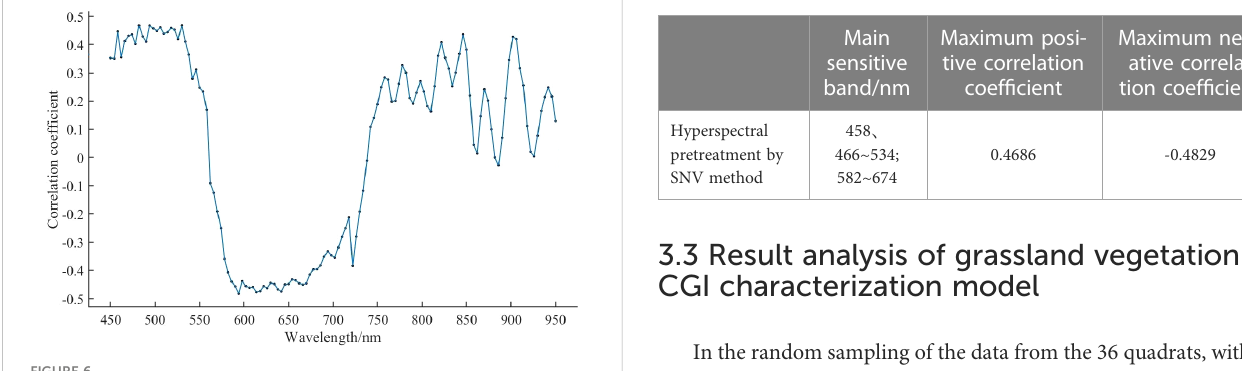
FIGURE 6 Correlation analysis of spectra and CGI.